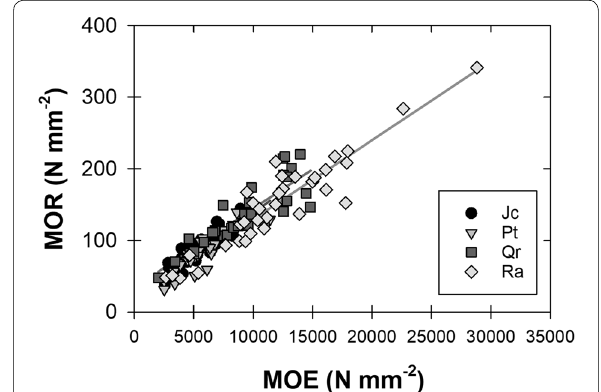
Fig. 4 Modulus of elasticity (MOE) and modulus of rupture (MOR) were strongly correlated ( F 1,143 P < 0.001). Species abbreviations are included in Table